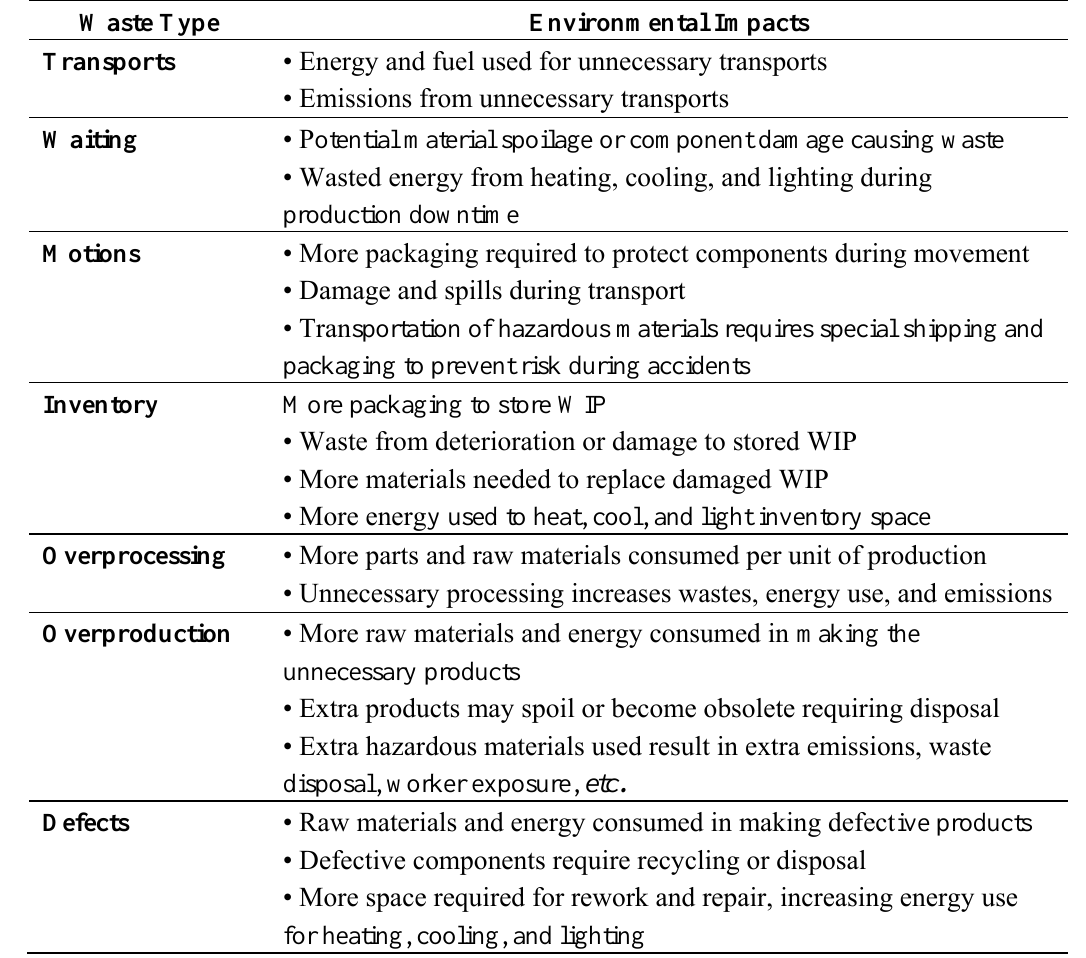
Table 1. Environmental impacts linked with manufacturing wastes (Adapted from